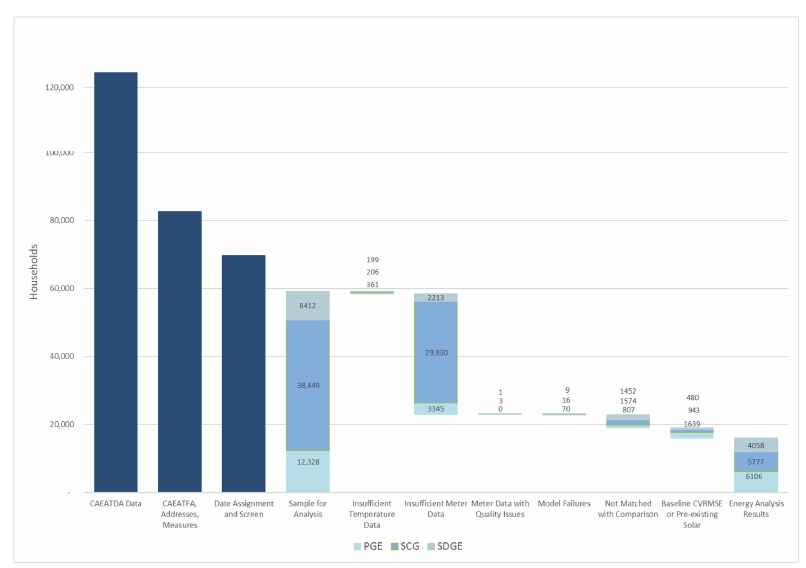
Figure A2. Gas sample attrition.